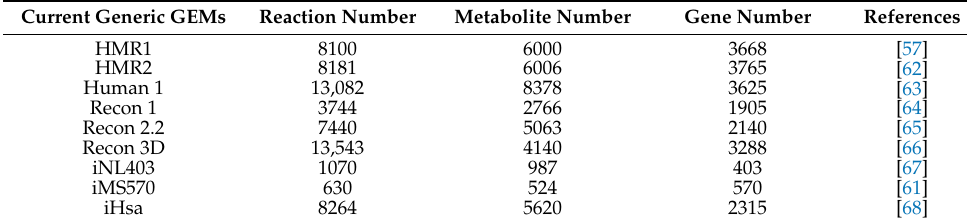
Table 2. Current generic metabolic